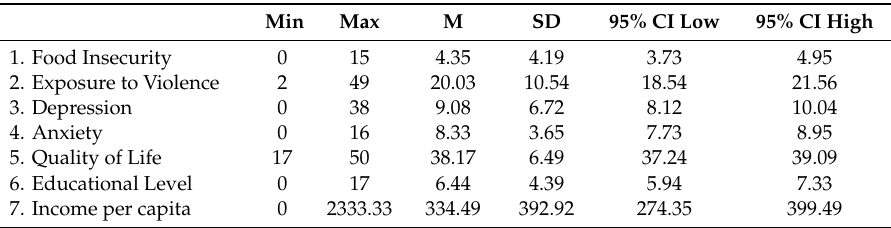
Table 1. Descriptive statistics of study